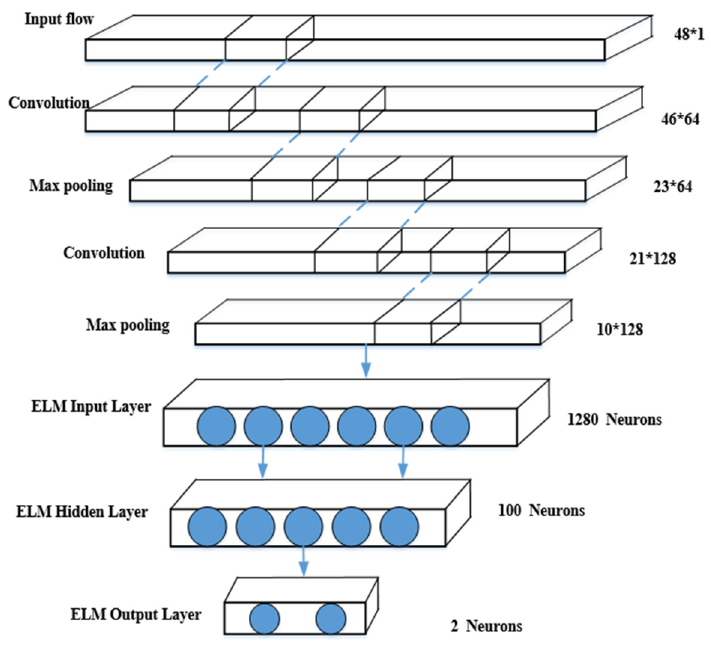
Figure 3. Deep learning hybrid model CNN-ELM.